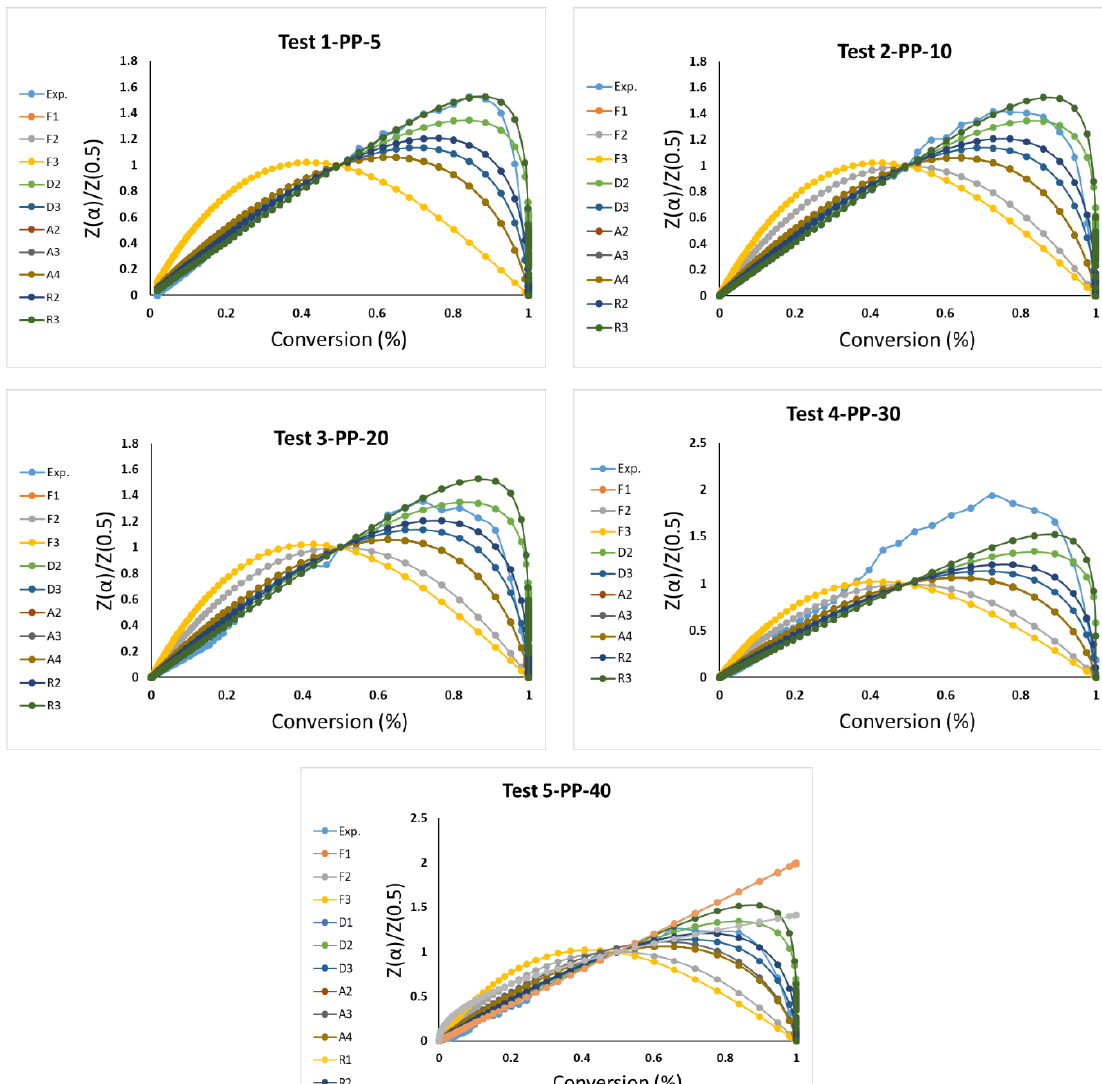
Figure 5. Masterplots of different kinetic models and experimental data of five tests.